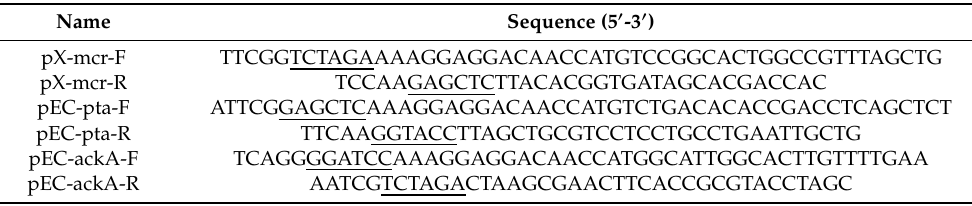
Table 3. Primers used in this